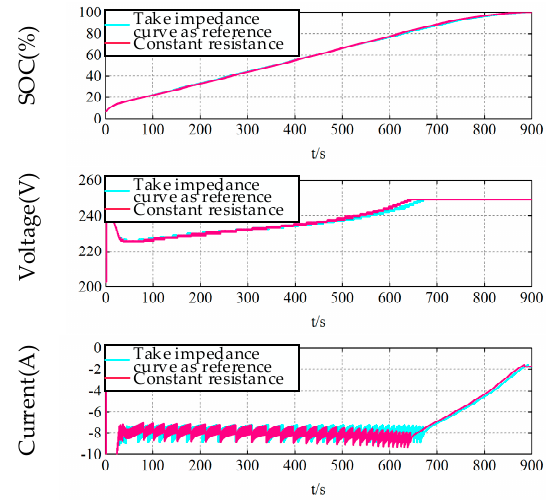
Figure 13. The characteristic curve of the primary side constant impedance control.